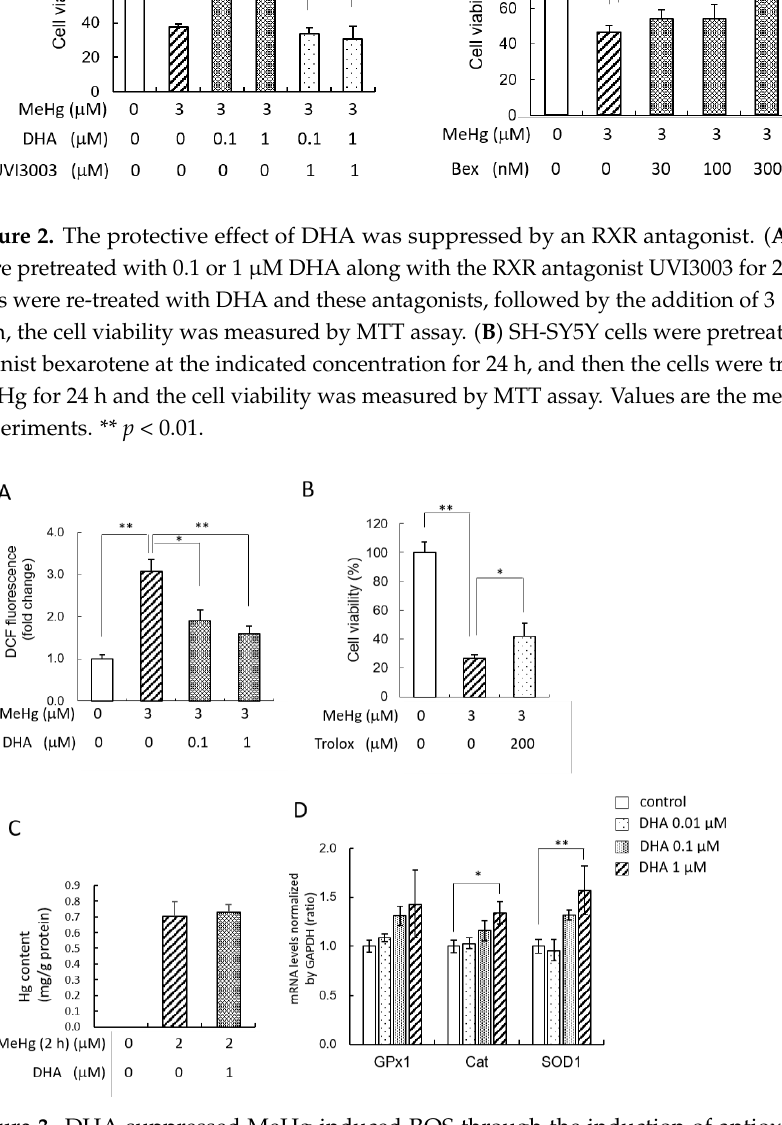
Figure 3. DHA suppressed MeHg-induced ROS through the induction of antioxidant genes. ( A ) SH-SY5Y cells were pre- treated with 0.1 or 1 µM DHA for 24 h, and then 3 µM MeHg and DHA were added to the cells. After a 2 h incubation, the intracellular ROS levels were measured using carboxy-H 2 DCFDA. ( B ) The cells were pretreated with 200 µM Trolox for 1 h, and then the cells were treated with 3 µM MeHg for 24 h. The cell viability was measured by MTT assay. ( C ) SH- SY5Y cells were pretreated with 1 µM DHA for 24 h, and then 2 µM MeHg was applied together with DHA to the cells for 2 h. After the cells were washed with PBS, the Hg content of the cells was determined using a direct thermal decom- position mercury analyzer. ( D ) SH-SY5Y cells were treated with DHA at the indicated concentration for 24 h, and the mRNA levels of GPx1 , catalase , and SOD1 were measured by real-time PCR. Values are the mean ± SD for 3 – 5 experiments. * p < 0.05; ** p <